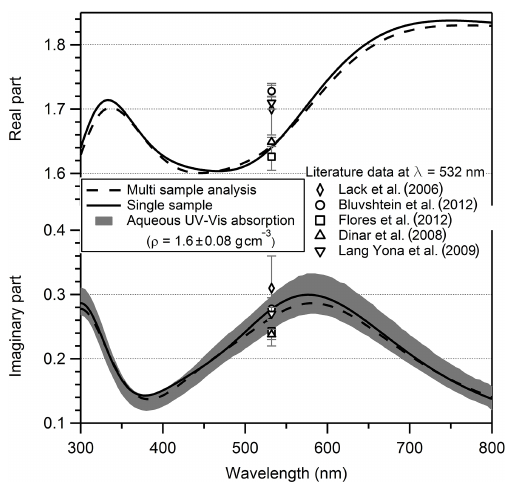
Figure 4. Complex RI results of spectroscopic ellipsometry mea- surements of nigrosin coating on Si oxide. Also shown are the re- sults of an imaginary part calculated from aqueous UV–vis mea- surements based on Sun et al. (2007) with a density value of 1.6gcm − 3 (Moteki et al., 2010). The range of the shaded area is the sum of the variance of the absorption measurements (about 2 to 5%) and 5% uncertainty on the reported density measurement technique (McMurry et al.,